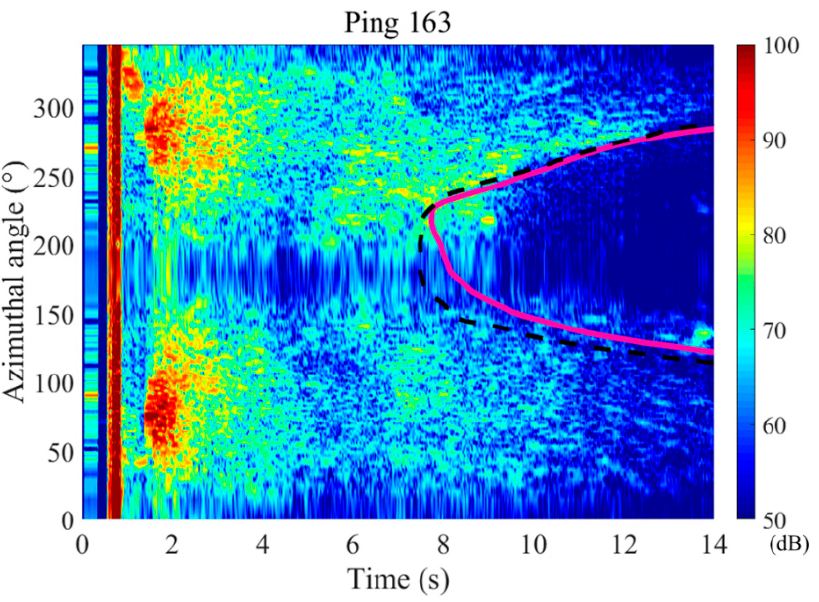
Figure 13. Comparison of measured BTR and two-way MDP travel time+ curves using the depth- bistatic approach (solid line) and the full bistatic approach (dashed line) for ping 163.